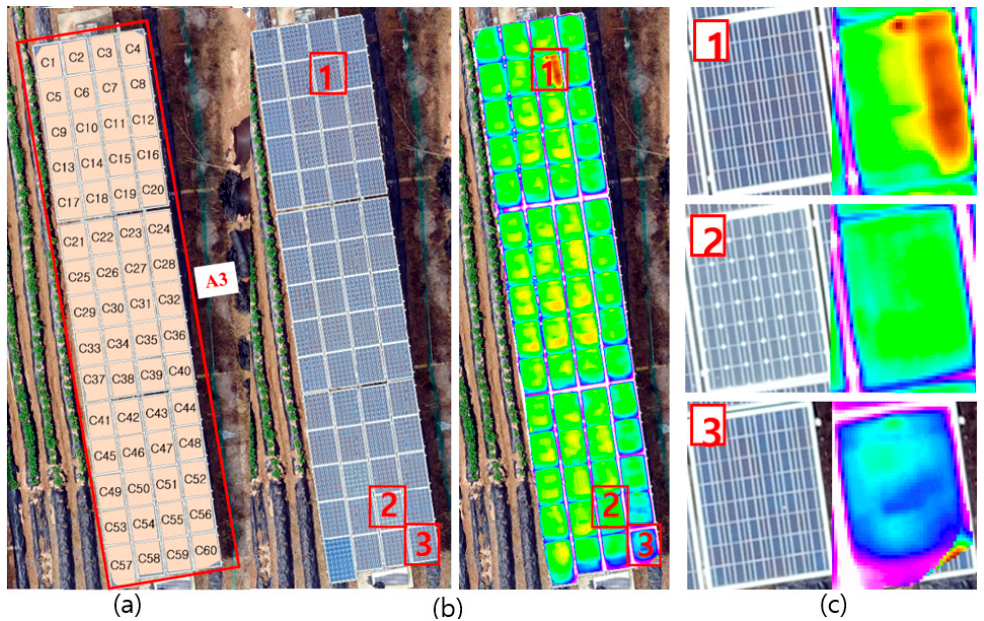
Figure 9. Comparison of the code number of each panel and the status of normal or abnormal optical and thermal infrared orthographic image panel. ( a ) Number of each panel; ( b ) Comparison of RGB image and temperature distribution by panel; ( c ) Comparison of three features.